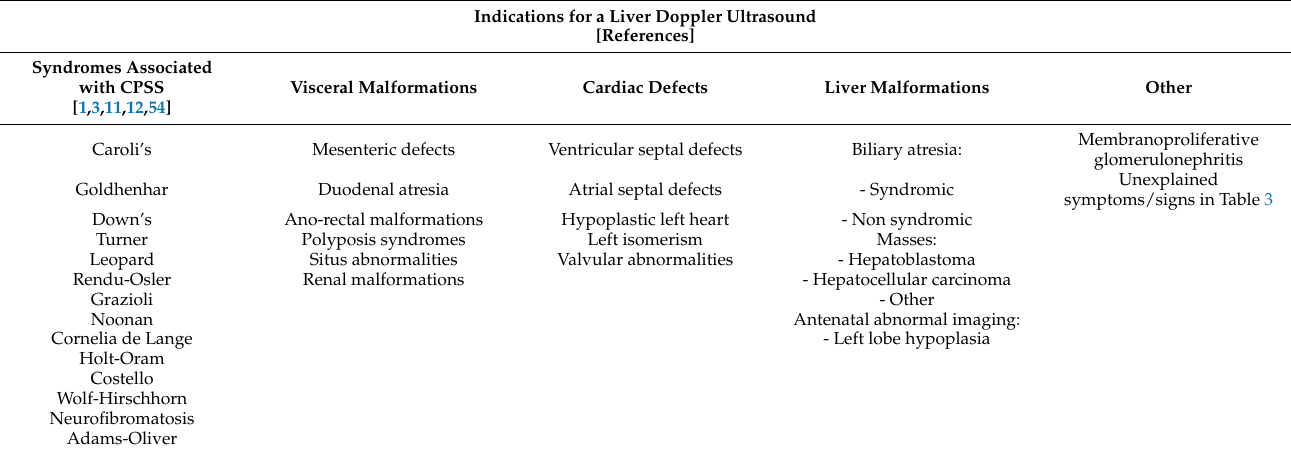
Table 2. Indications for liver Doppler US.